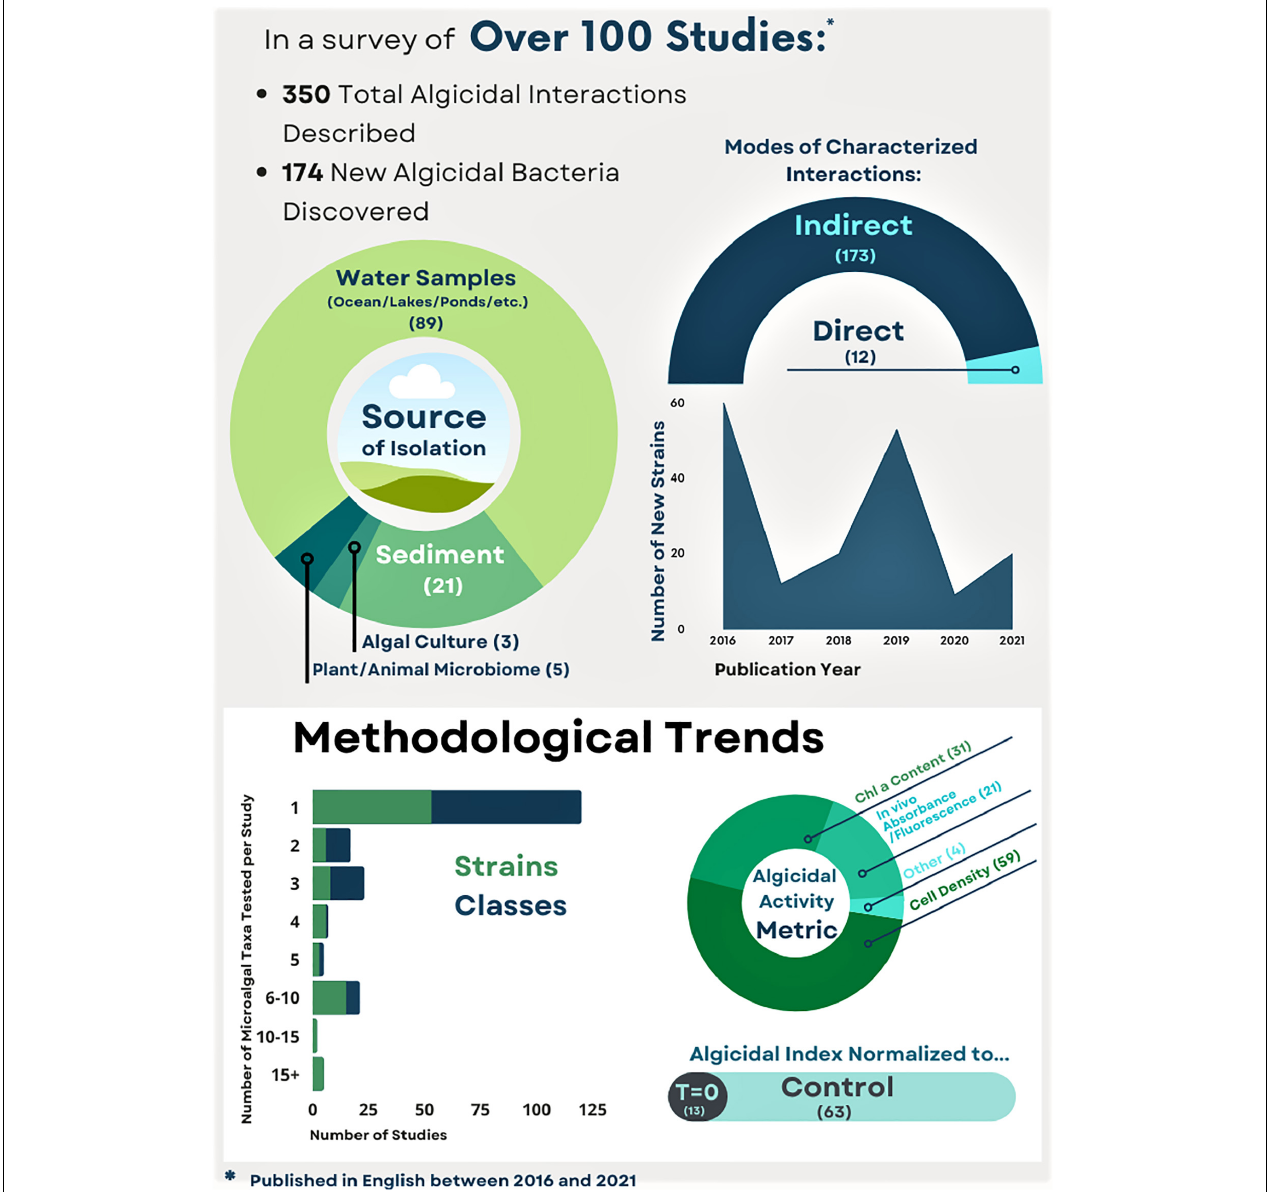
FIGURE 3 | Infographic summarizing algicidal bacteria studies published in English between 2016 and 2021. Numbers of interactions and new strains, modes of attack, and methodological trends are included. For details, see doi: